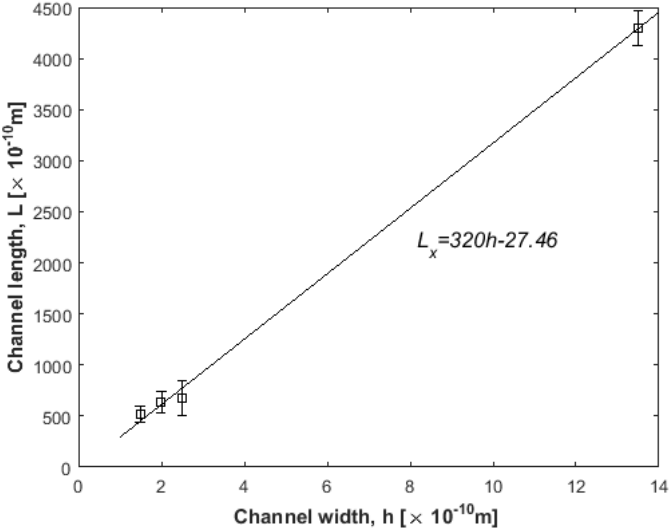
Figure 11. Calculated minimum channel length vs. channel width (squares) to be incorporated for the